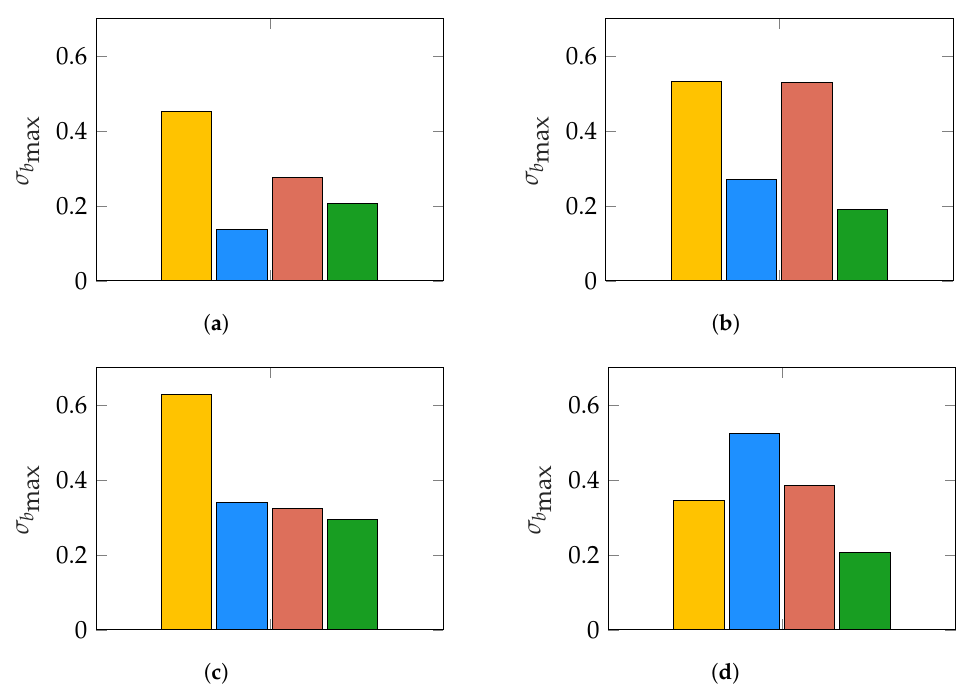
Figure 7. Results of evaluating σ b for the same noise conditions as in Figure 6. Bars correspond to max P ( W 0 ) (yellow), ι (blue), ι (red), and ι (green). ( a ) Noise conditions: η b = 10 dB, η m = 10 dB; min MAI RR1 RR2 ( b ) noise conditions: η b = 5 dB, η m = 5 dB; ( c ) noise conditions: η b = 0 dB, η m = 0 dB; ( d ) noise conditions: η b = − 5 dB, η m = 0